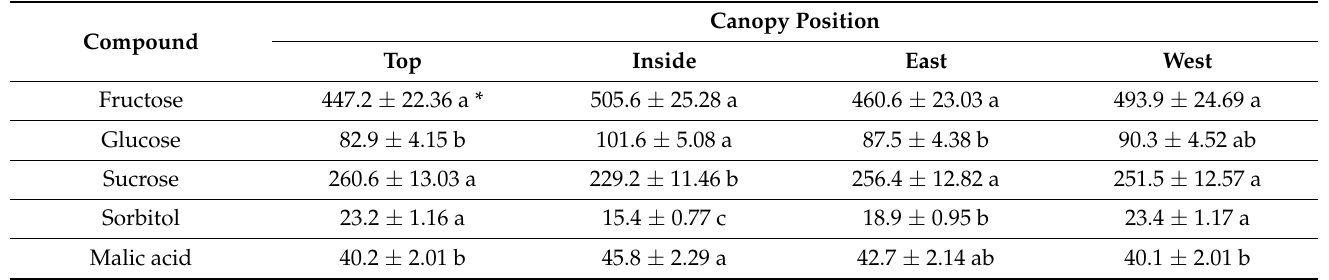
Table 5. Effect of fruit position in tree on apple sugar, sorbitol and malic acid composition, mg g −